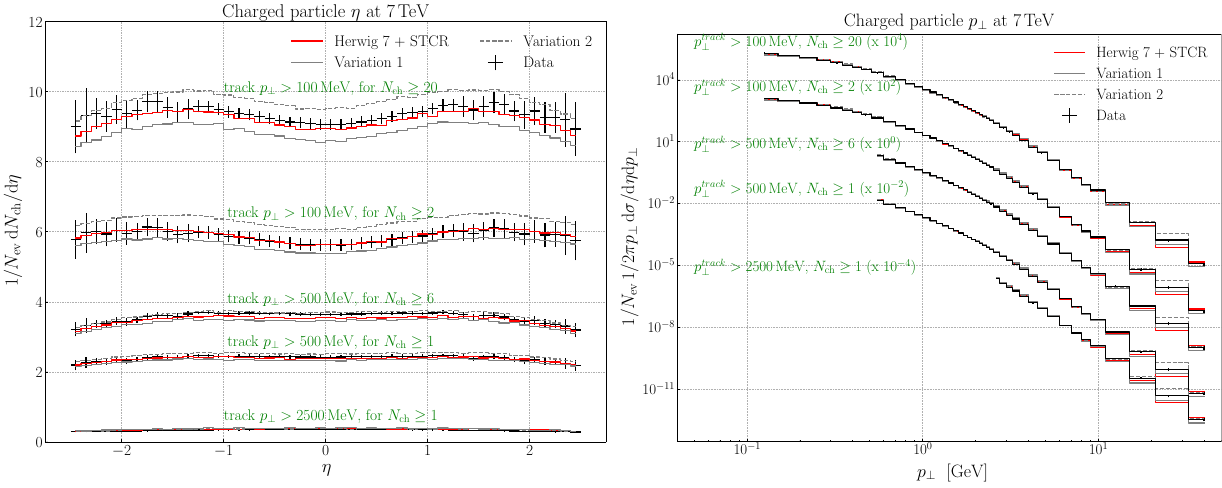
is purely in the spacetime length and minimum virtuality parameters of our model as defined in Fig. 8 and in the corresponding text